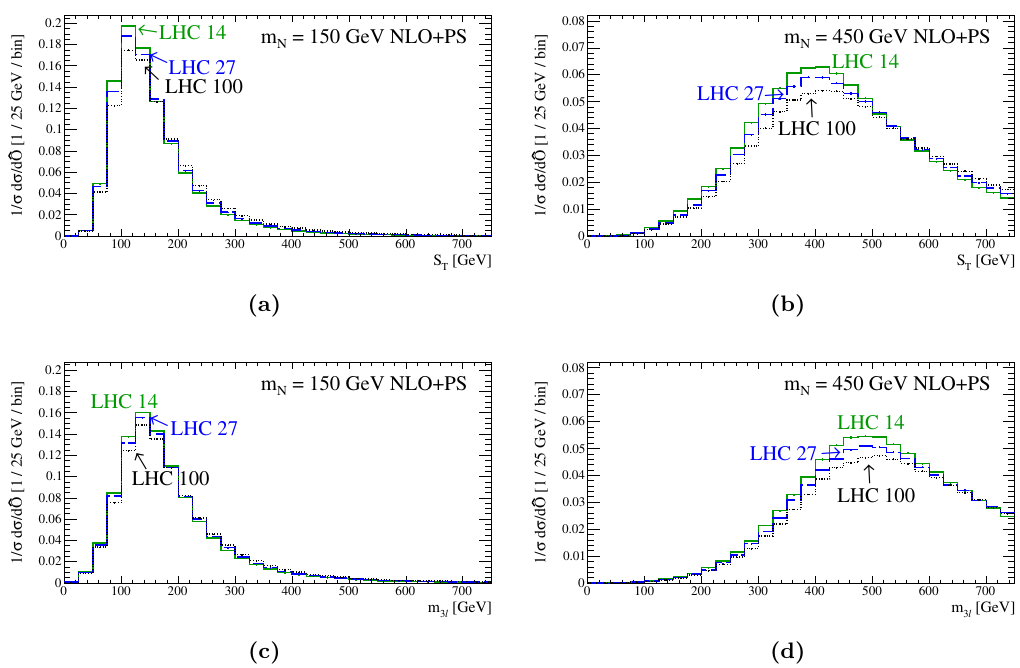
Figure 12. Same as (cid:12)gure 11 but for (a,b) S T and (c,d) m 3 ‘ of the three leading charged lepton. charged leptons with p T < p ‘ 3